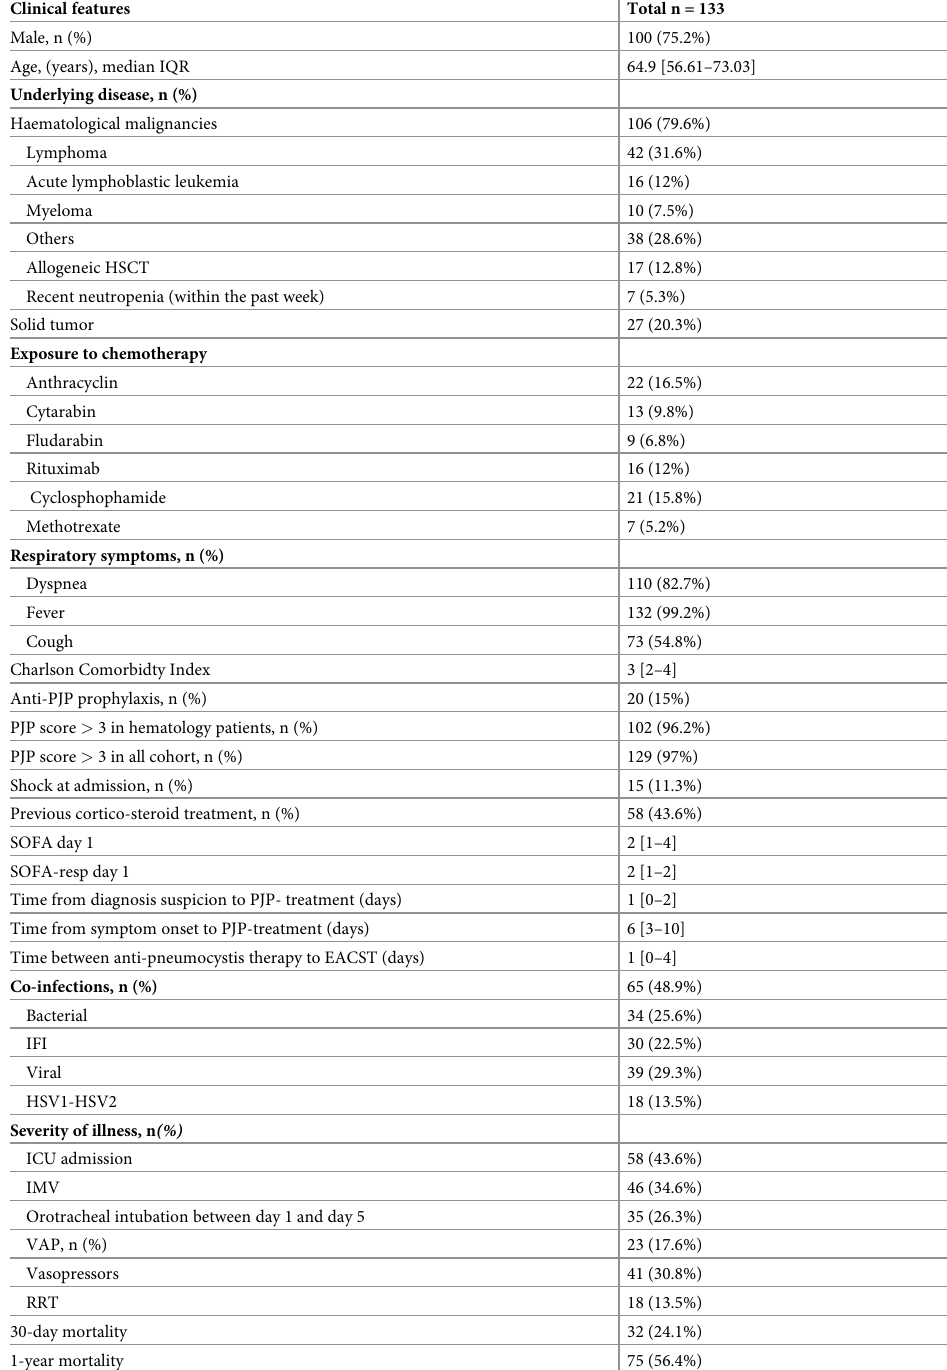
Table 1. Baseline patients characteristics. Clinical